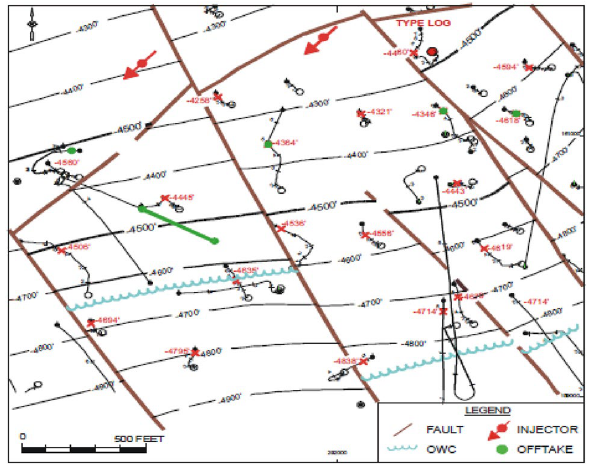
Fig. 3 Structure contour map, upper cruse sands-EOR 4